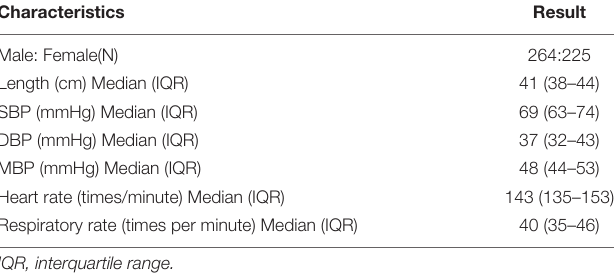
TABLE 1 | General characteristics of the preterm babies.